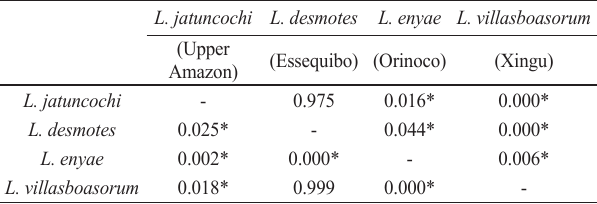
Tab. 5. P-values for post-hoc Tukey’s pairwise comparisons on the principal component scores from the linear